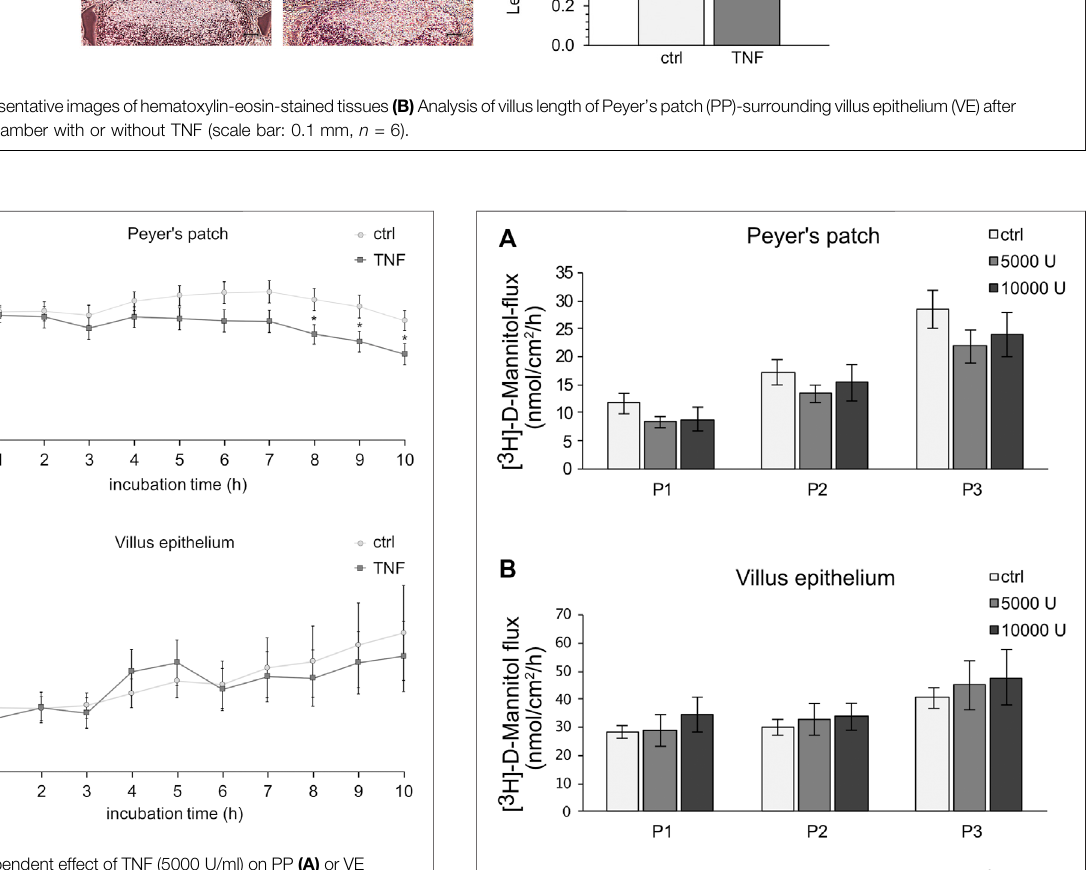
FIGURE 4 | Paracellular permeability of PP (A) and VE (B) by using [ 3 H]- D-Mannitol fl ux measurements. After an incubation of 8 h with TNF (5,000, 10,000 U/mL), fl ux measurements were carried out for 2 h, resulting in three fl ux periods of 40 min each. Data are presented as mean ± SEM ( n =